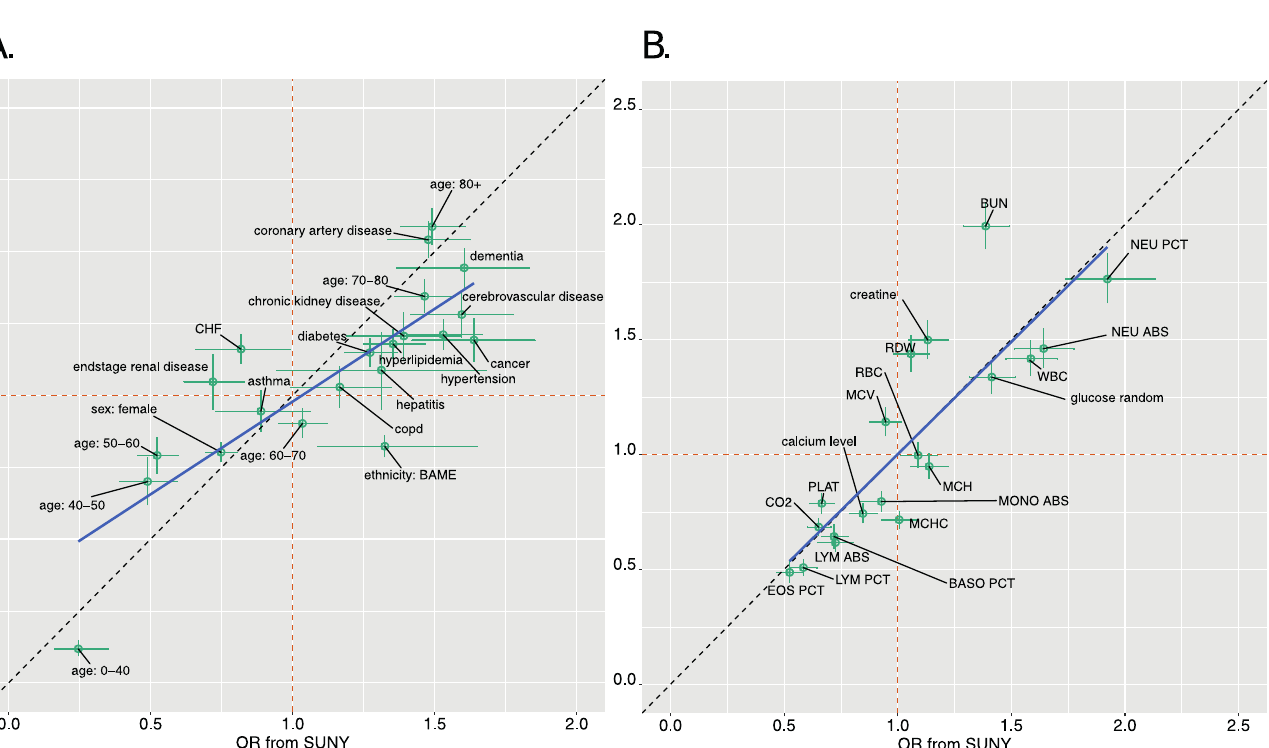
PLOS ONE | https://doi.org/10.1371/journal.pone.0272442 August 18,